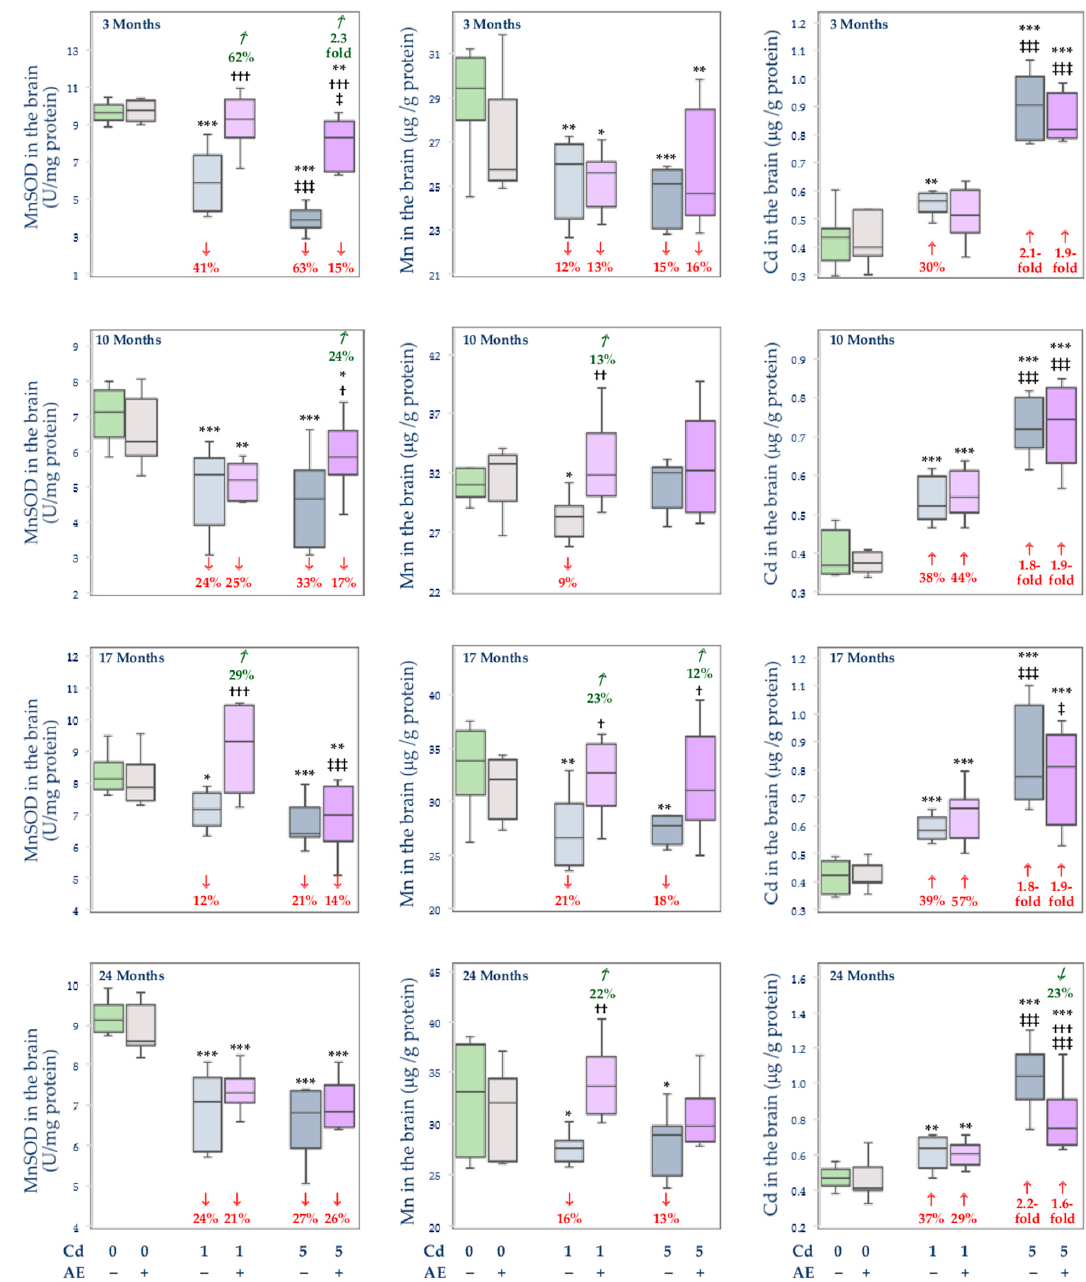
Figure 10. The activity of MnSOD and the concentrations of Mn and Cd in the mitochondrial fraction of the brain in particular experimental groups. The rats received Cd in the diet at the concentration of 0, 1, and 5 mg/kg and/or 0.1% AE as the only drinking fluid (“+”, administered; “ − ”, without administration). Data represent a median and 25–75% confidence interval (the horizontal lines within the bars presenting the confidence interval represent median values), as well as the minimum and maximum values for eight rats in each experimental group (except for seven animals in the AE, Cd1, and Cd5 groups after 24 months). Statistically significant differences: * p < 0.05, ** p < 0.01, *** p < 0.001 vs. control group; † p < 0.05, †† p < 0.01, ††† p < 0.001 vs. respective group receiving Cd alone (Cd1 or Cd5 group); ‡ p < 0.05, ‡‡‡ p < 0.001 vs. respective group receiving the 1 mg Cd/kg diet alone (Cd1 group) or with the AE (Cd1 + AE group) are marked. The values below and above the bars indicate percentages change or folds of changes compared to the control group ( ↓ , decrease; ↑